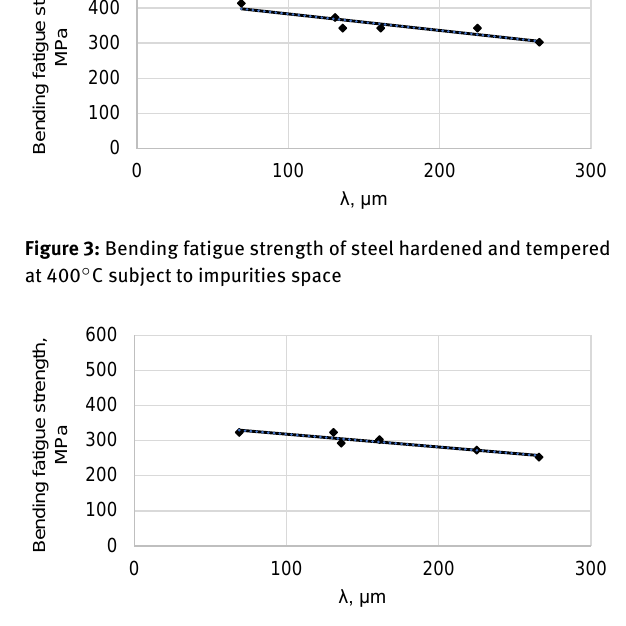
efficients r at